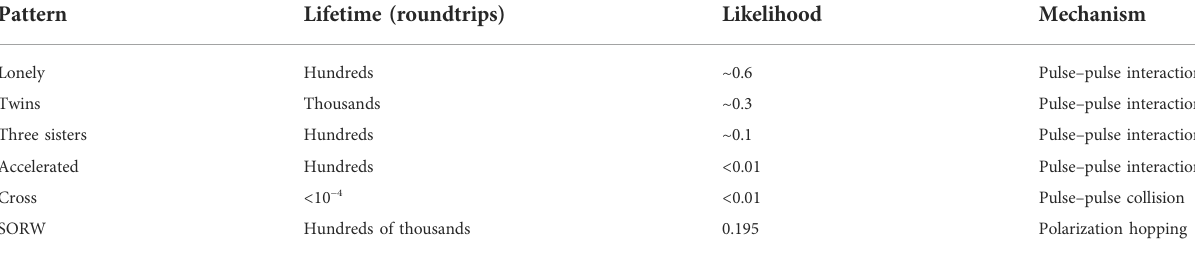
TABLE 1 Observed RW pattern ’ s lifetime, its likelihood, and mechanism. Pattern Lifetime (roundtrips) Likelihood